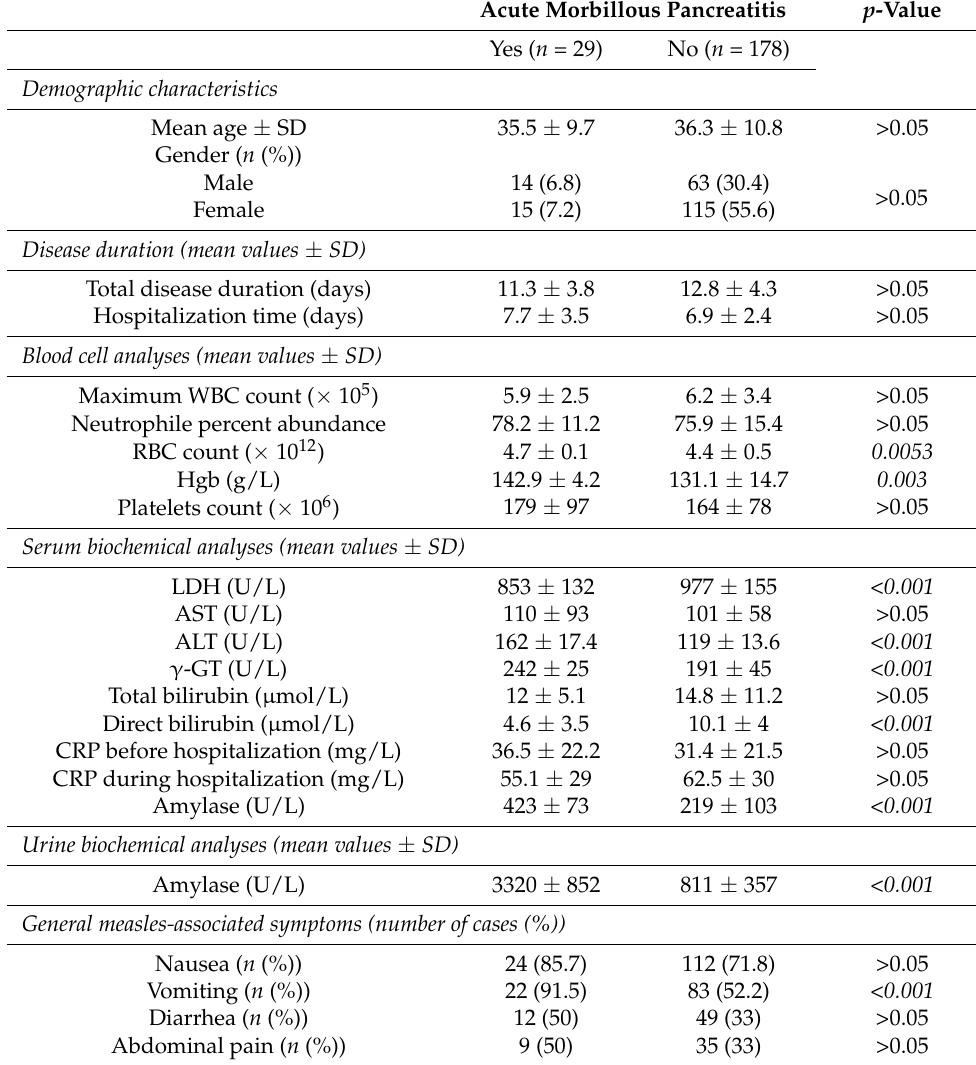
Table 1. Descriptive data and statistical analysis obtained from subjects with and without acute morbillous